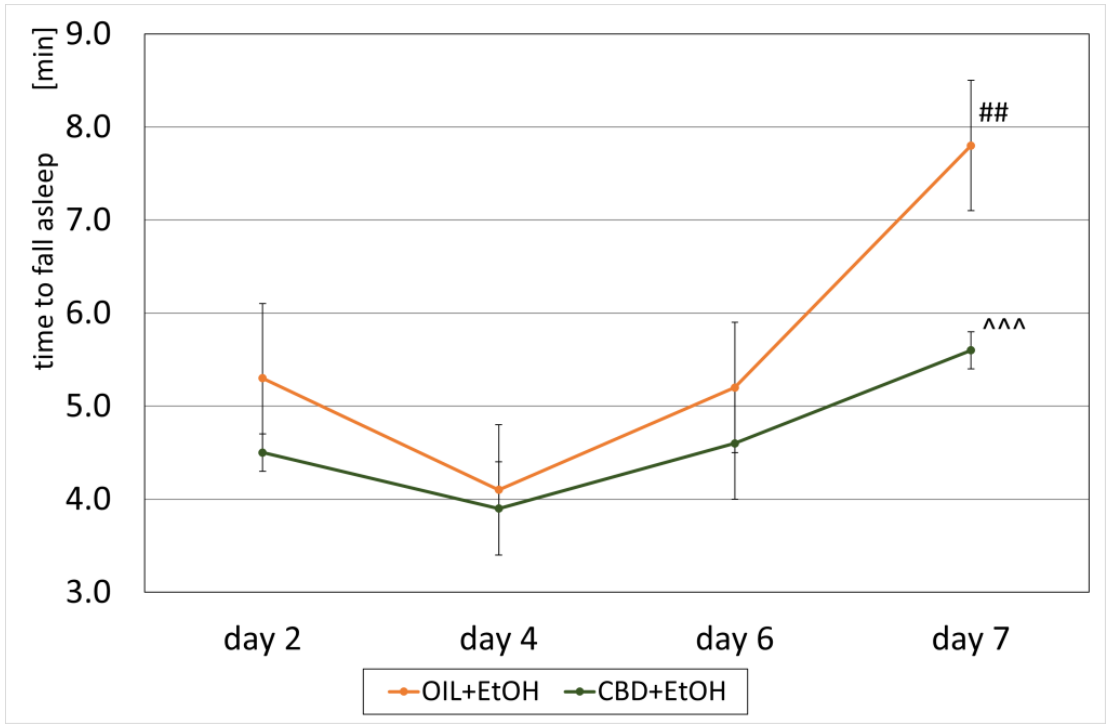
Figure 4. The effect of repeated CBD (cannabidiol; 20 mg/kg, p.o.) or OIL (rapeseed oil) administration once a day for 8 days on EtOH-induced (ethanol; 3.0 g/kg/day, i.p.) time to fall asleep on selected days (2, 4, 6, 7). Mean ± SEM, n = 9. Legend: ##—a statistically significant vs. all previous days in OIL + EtOH, p < 0.01; ˆˆˆ—a statistically significant vs. OIL + EtOH on a given day, p <